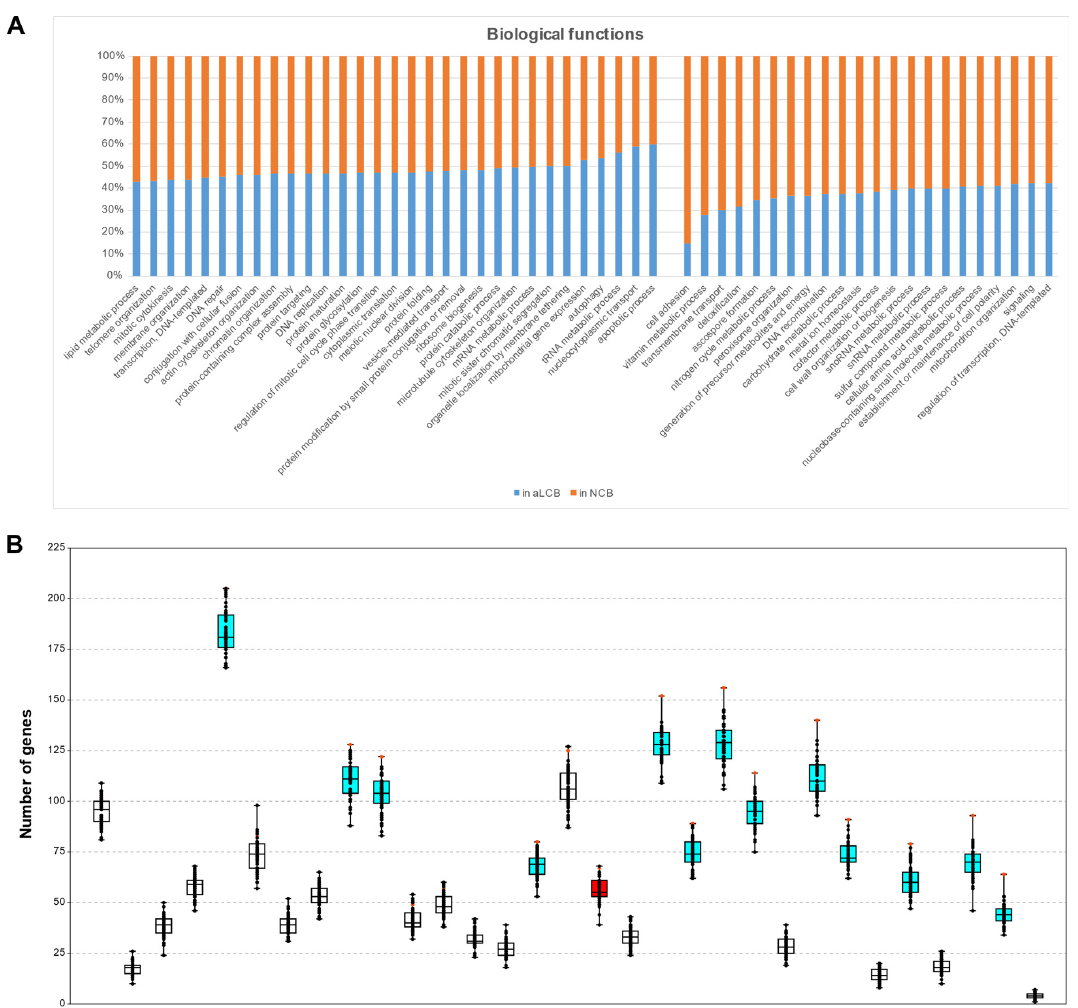
Figure 6. Genes of certain GO categories tend to cluster to the aLCBs. ( A ) Proportion of genes from different GO categories situated in the aLCBs and outside of aLCBs (NCBs). The first 31 categories (from left to right) are overrepresented in the aLCBs. ( B ) Data of 50 random sets of the 31 GO categories whose genes tend to cluster to the aLCBs (order of the GO categories is the same as above). Red dots on the whiskers show the real values observed in the genome of S. pombe , black dots indicate the values of the random sets. Real values are significantly different from the random sets in all the cyan and red coloured boxes according to the randomisation p values. Cyan colours indicate those categories which remained significant after the single-case t -probes, too. Red colour shows the only GO category (meiotic nuclear division) which showed significant clustering according to the randomisation p , but not after the single-case t -probe. There were 13 GO categories whose genes showed significant enrichment in the